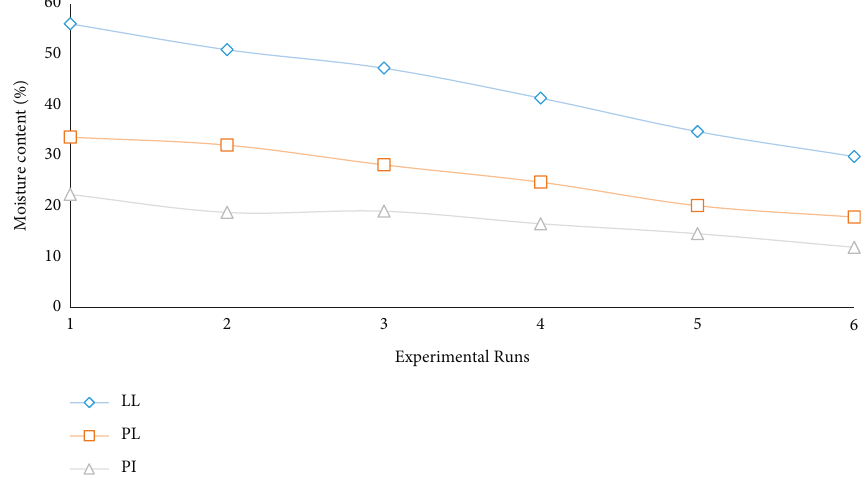
Figure 3: Consistency limit test